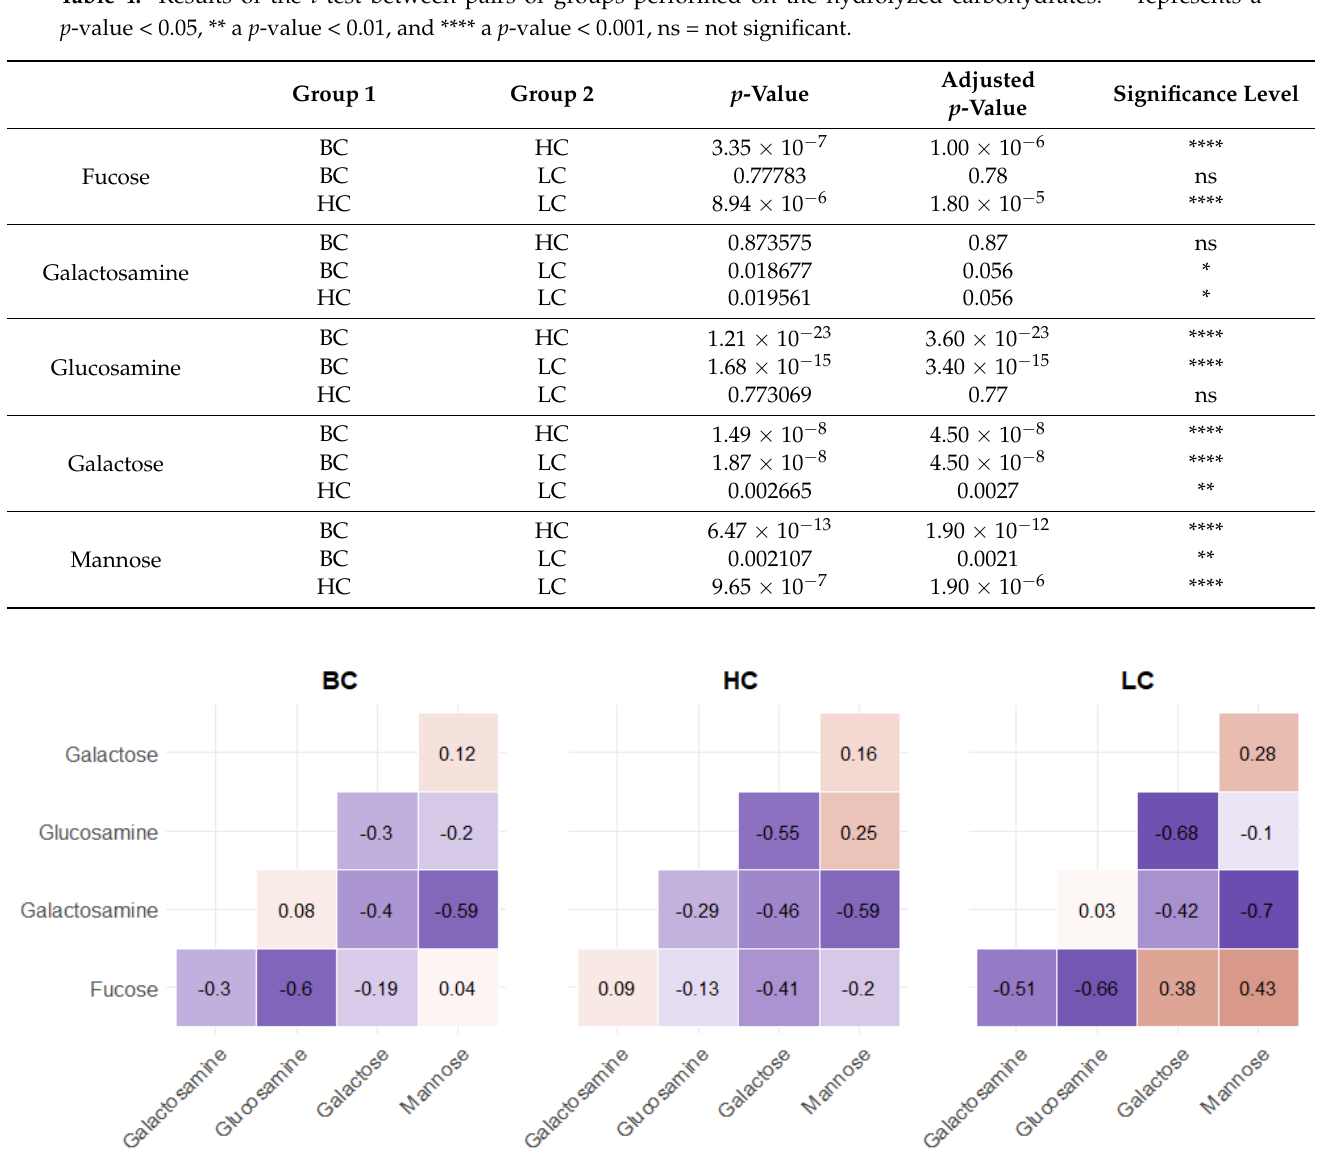
Figure 3. Matrix of correlation plots among the hydrolyzed carbohydrates in each group of samples. Interestingly, the stronger correlations had all negative values. A significant negative correlation was always observed between galactosamine and mannose ( − 0.6), and it was even more pronounced in the LC samples ( − 0.7). A quite strong negative correlation (between − 0.6 and − 0.7) was also observed between fucose and glucosamine but only in the pathological samples. Nevertheless, in the BC samples, only the correlations between fucose and glu- cosamine and between galactosamine and either galactose or mannose resulted significant by looking at the corresponding p -values. Correlations with galactosamine were